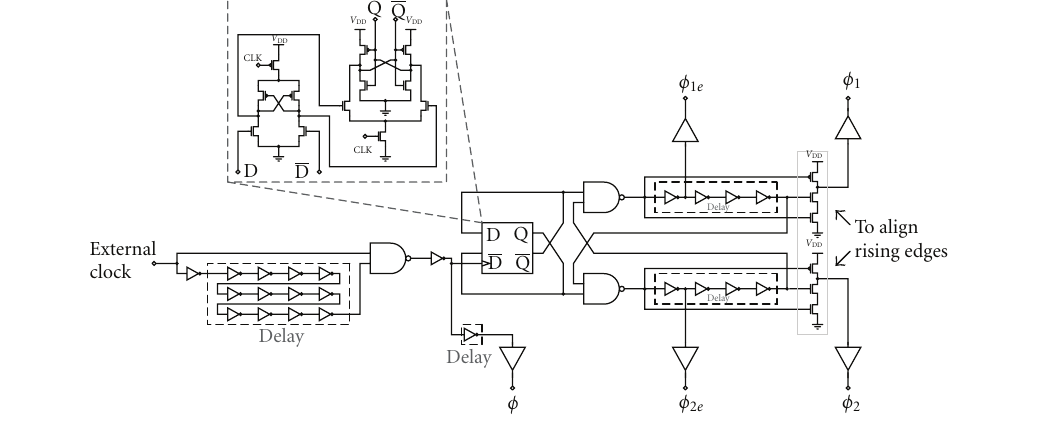
To align rising edges